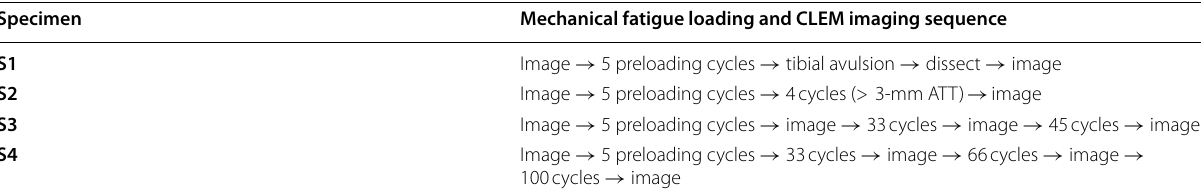
Table 2 Summary of the repeated measures experimental design for each single (S) knee